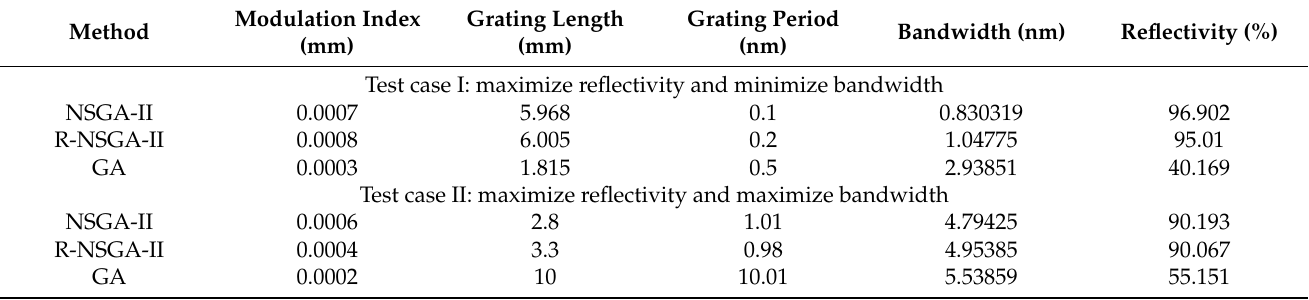
Table 2. Comparison between NSGA-II, RNSGA-II, and